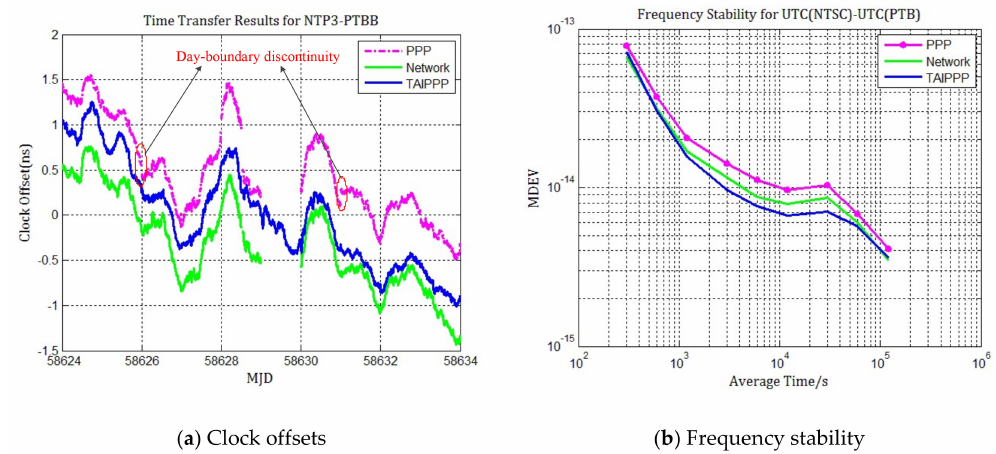
Figure 7. Time transfer and frequency stability results for UTC(NTSC)-UTC(PTB). ( a ) Station clock o ff sets for 10 day batches using PPP (purple), network processing (green) and TAIPPP solutions (blue); ( b )Frequency stability for PPP (purple), network processing (green) and TAIPPP solutions